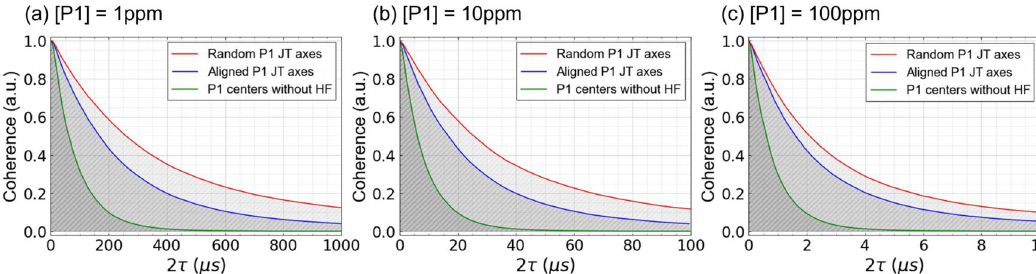
Fig. 4 Spin coherence of NV ensembles in a P1 bath. a – c Hahn-echo coherence of NV ensembles (red line) for [P1] = 1 ppm ( a ), 10 ppm ( b ), and 100 ppm ( c ) compared with the coherence function obtained with two hypothetical P1 bath models: P1 bath with no-hyper fi ne interaction (green line) and a P1 bath in which all the JT axes are polarized along the (111) direction (blue line).